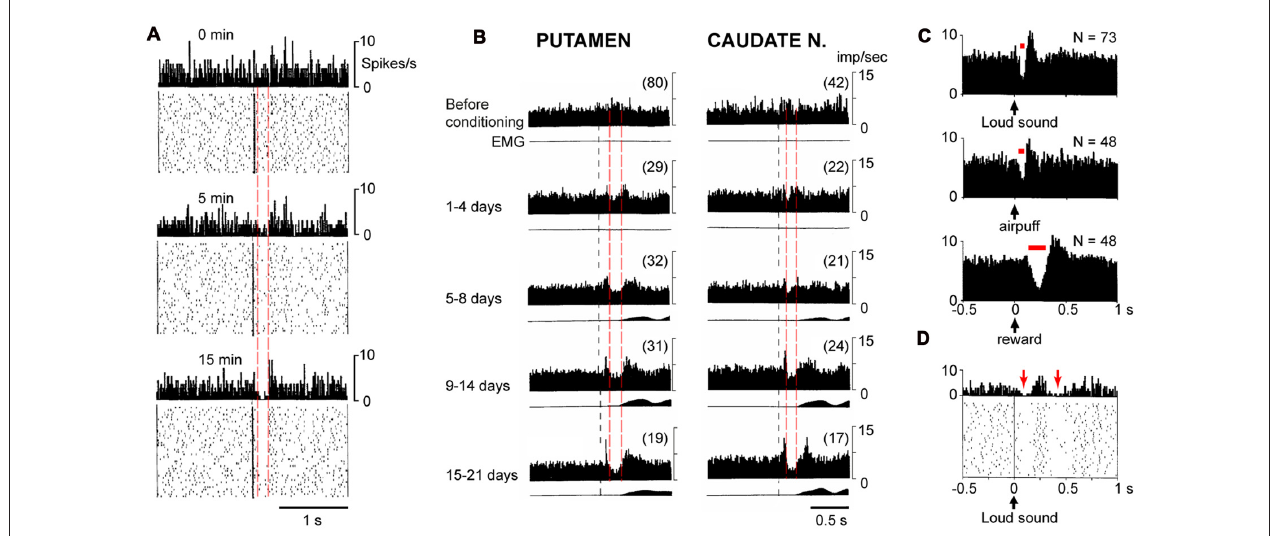
FIGURE 1 | Different pause responses in tonically active neurons (TANs) in vivo show divergent and constant properties. (A) Development of a pause response in a typical TAN during a new conditioning at times 0, 5 and 15 min. The pause develops in amplitude but not in latency or duration ( dashed red lines ). Each panel represents 5 min of recording, upper , peri-stimulus time histogram (PSTH), lower , rasters of individual sweeps. Adapted with permission from Aosaki et al. (1994b). (B) Development of a pause response in a population of TANs in vivo ( n = 17–80) during conditioning over days. Pauses in the peri-stimulus time histogram (PSTH) develop in amplitude but not latency and duration ( dashed red lines ), in monkey putamen ( left ) and caudate nucleus ( right ). Lower trace in each panel shows the movement (EMG) which occurs later than the pause. Adapted, with permission, from Aosaki et al. (1994b). (C) Pause responses in a population of TANs in the same animal have different latency and duration ( red bar ) when a loud sound, air puff, or reward were applied. Adapted with permission from Ravel et al. (2003). (D) A TAN can show two pauses ( red arrows ) after a stimulus (loud sound, black arrow ) is applied, PSTH ( upper ) and raster data ( bottom ). Adapted with permission from Ravel et al.